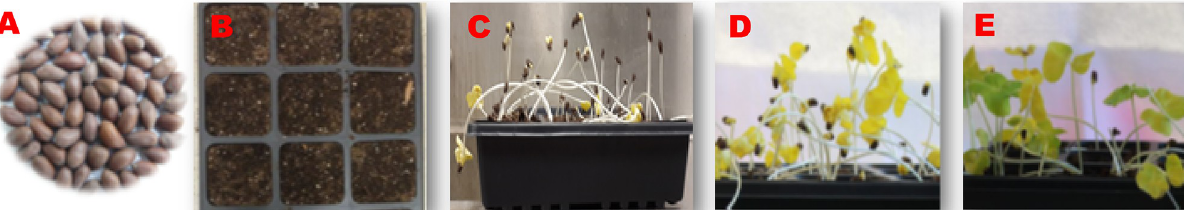
Fig 2. Explant preparation. (A) Coker-312 delinted seeds, (B) Seeds sown in moist sunshine mix soil in darkness, (C) Emergence of cotyledonary leaves and whitish hypocotyls, (D) Hypocotyls growth in dark (yellowish appearance), (E) Hypocotyls turned green when subjected to sunlight for 48